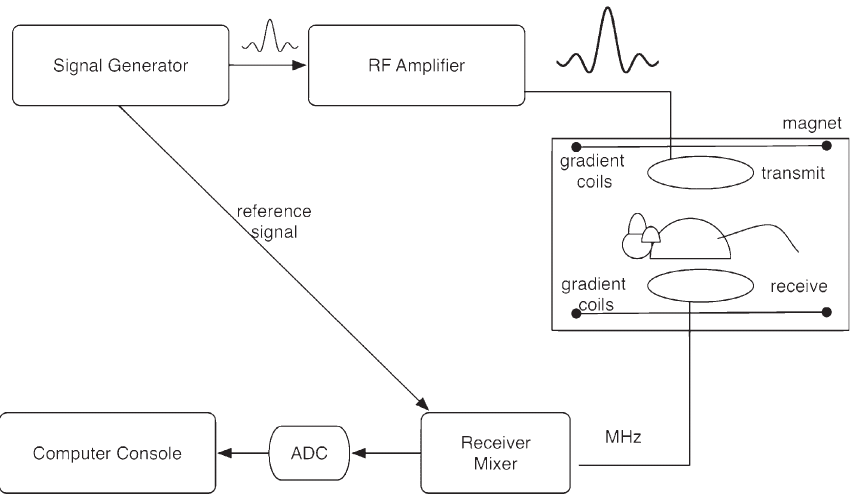
Fig. 2. The basic elements of the MR system include an RF pulse generator, whose signal is amplified before being sent to the transmitter coil. The same signal is used to synchronize the acquisition of the MR signal coming from the receiver coil. After unmixing and passing through the analog-to-digital converter, the real and imaginary components are used to reconstruct and visualize the MR image either by the same console computer used to control the RF and the gradients, or